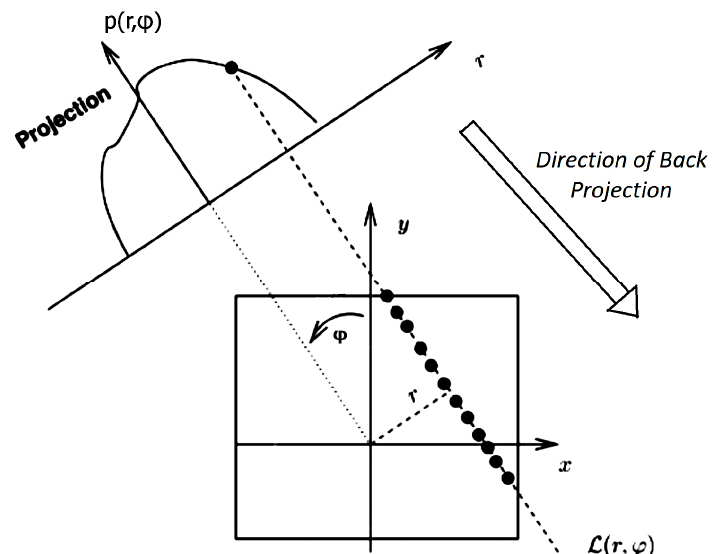
Figure 3. Back projection. The information of the sinogram 𝑝 ( 𝑟 , 𝜑 ) is spread back to the position of the initial image.